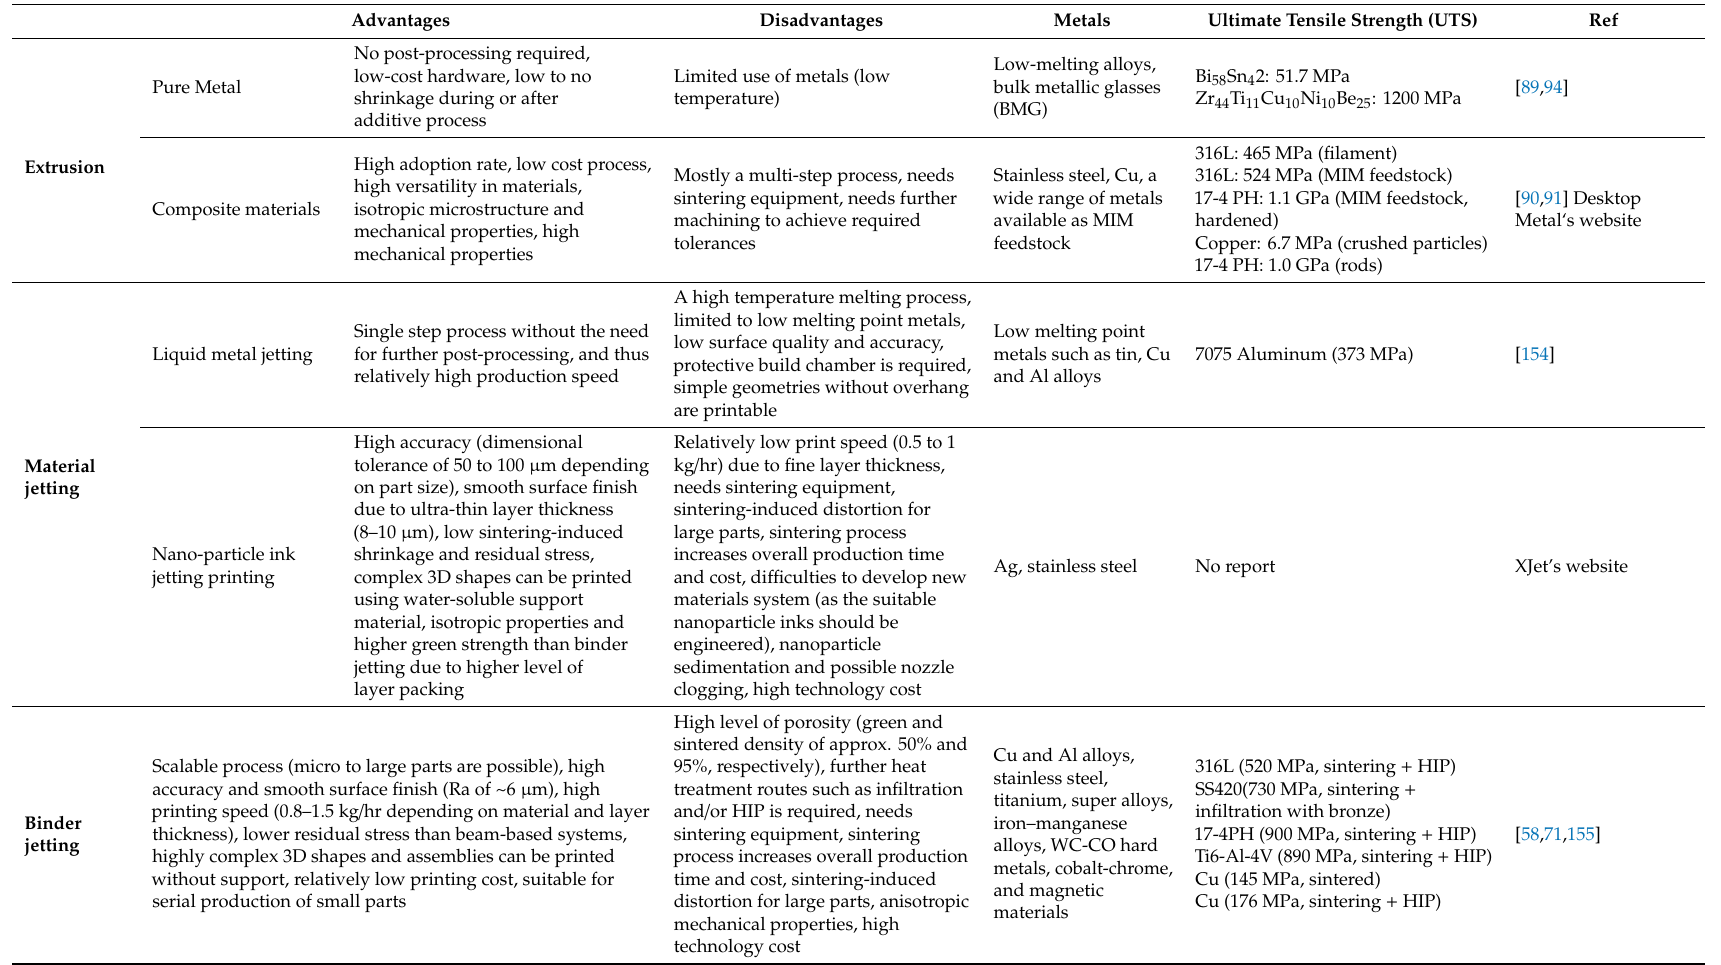
Table 3. Comparison of various beamless metal AM